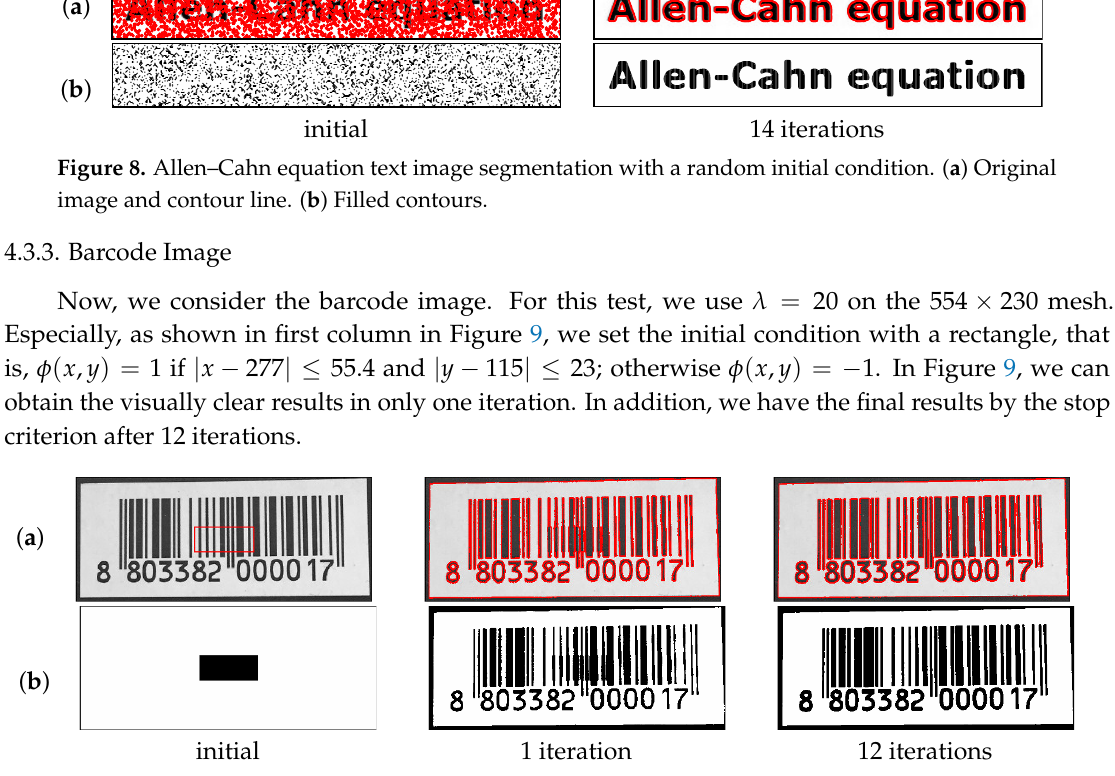
Figure 9. Barcode image segmentation with a rectangle initial condition. ( a ) Original image and contour line. ( b ) Segmented